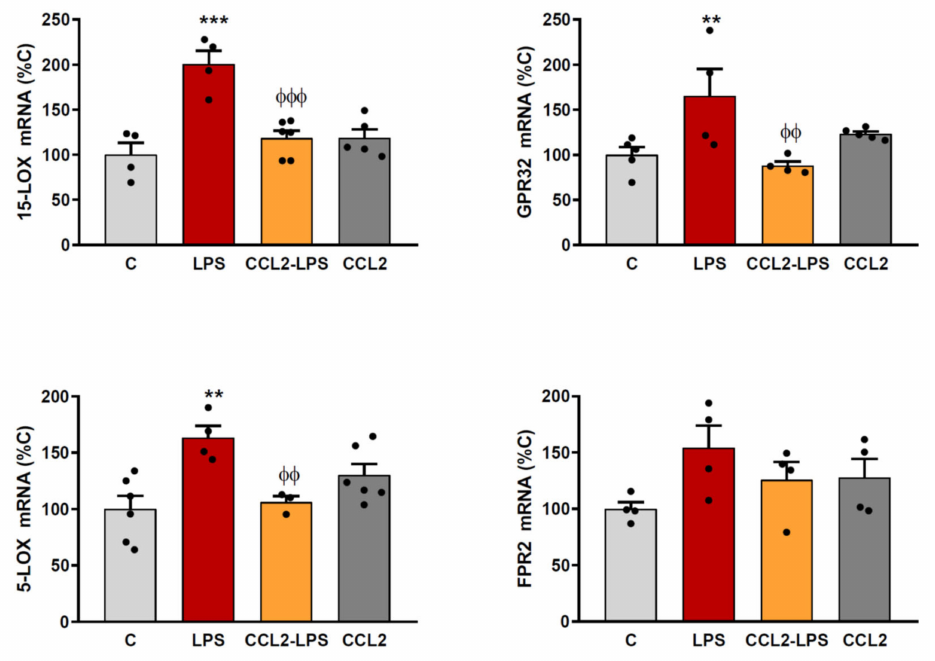
Figure 2. CCL2 prevents the expression of pro-resolution markers. Astrocyte cultures were incubated with or without CCL2 (100 ng/mL). Twenty-four hours later, the whole medium was replaced in all wells, maintaining CCL2 where it was used for pre-treatment and adding LPS (0.1 g/mL) to indicated groups. Six hours later, RNA was isolated and 15-LOX, 5-LOX, FPR2 and GPR32 mRNA levels determined by RT-PCR. Data are means ± SEM of n = 6 replicates per group. *** p < 0.001, ** p < 0.01 vs. C. φφφ p < 0.001, φφ p < 0.01 vs. LPS. φ